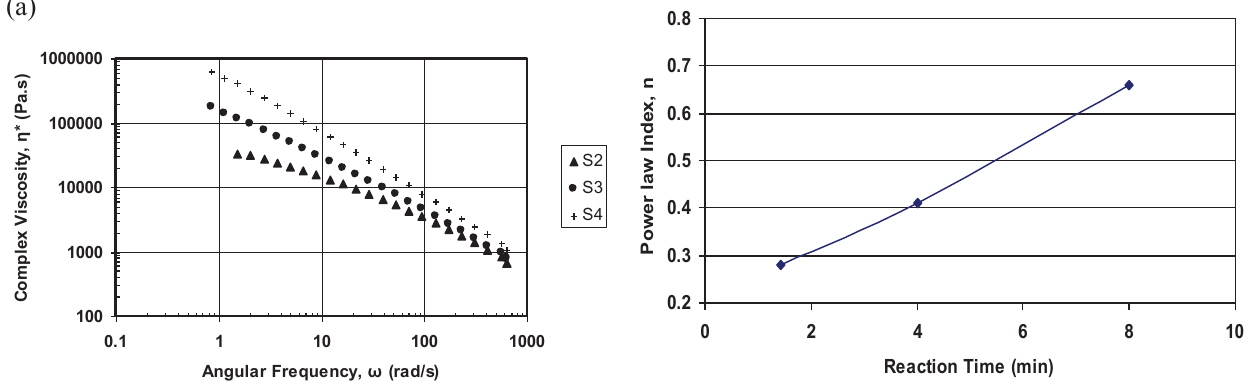
Fig. 4. The power law index of the samples collected at different reaction time.